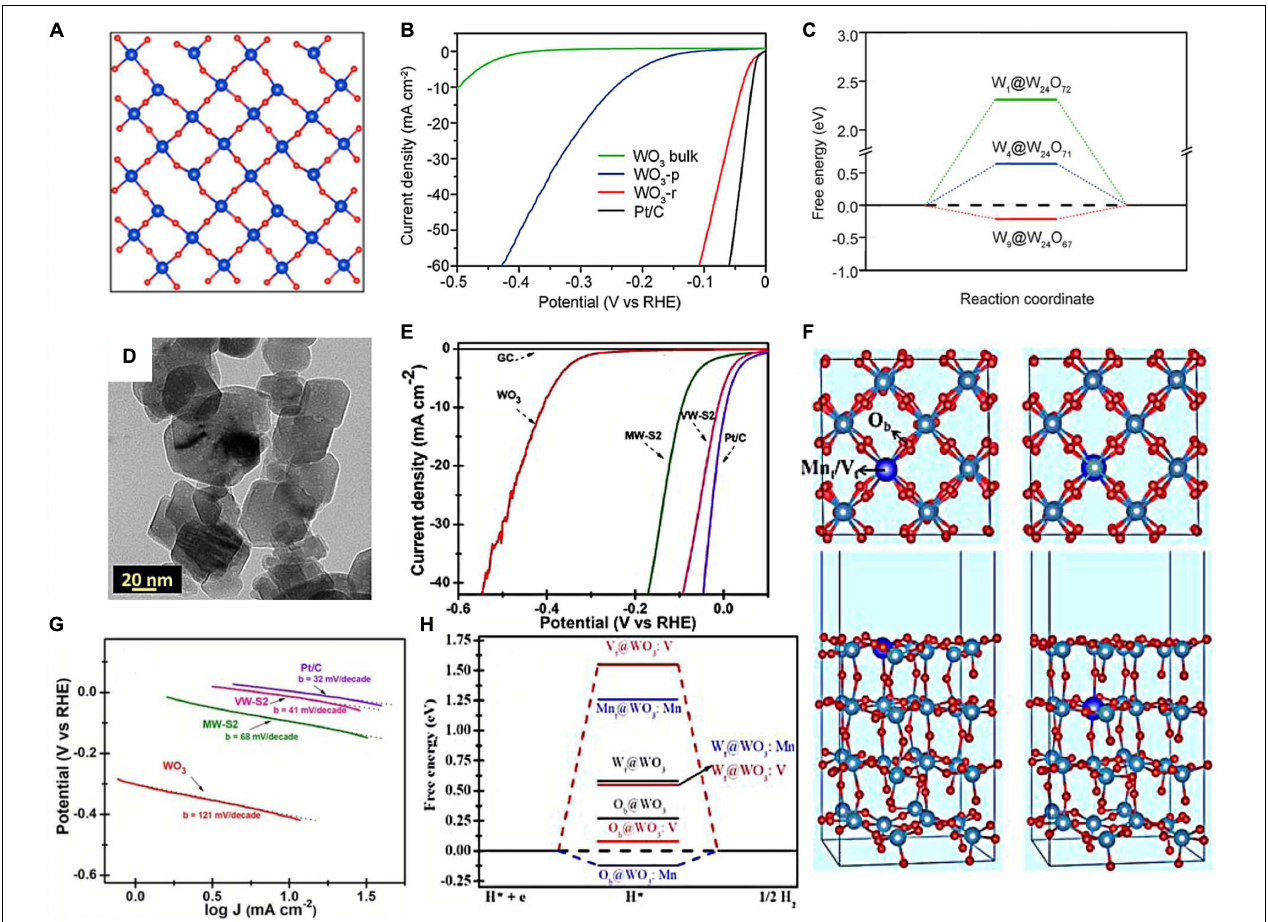
√ √ 2 × 2) R45 ◦ slab with all terminal O atoms as well as one bridging O atom removed (denoted as W 24 O 67 ). FIGURE 1 | (A) Crystal structure of WO 3 (010) ( (B) Polarization curves measured in H 2 saturated 0.5 M H 2 SO 4 solution for WO 3 -r NSs. (C) Free energy illustration for H 2 adsorption at the W site on the WO 3 (010) slab with different O vacancies. Reprinted with permission from Zheng et al. (2017). Copyright 2017, American Chemical Society. (D) Transmission